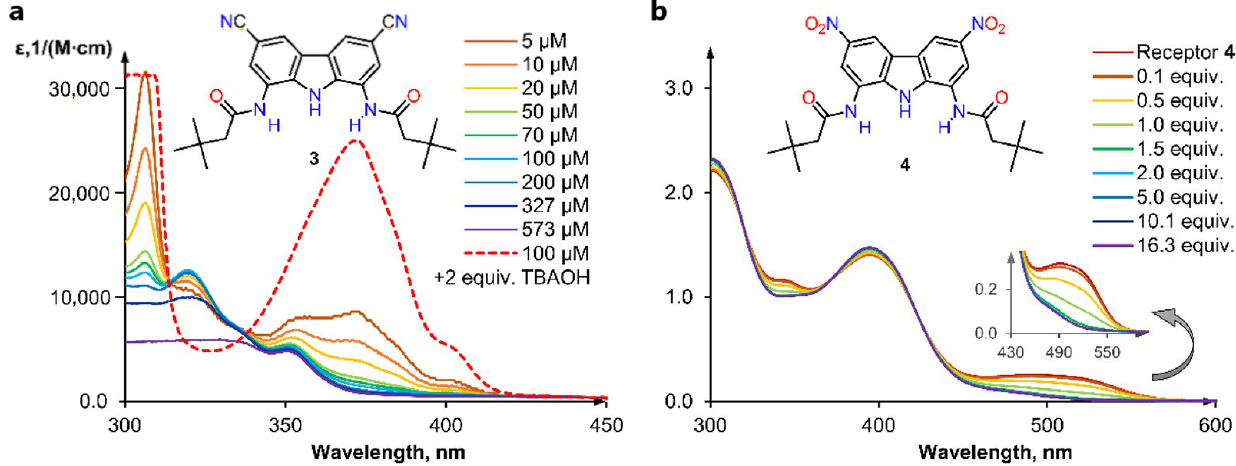
Figure 5. Self-ionization studies. ( a ) Self-ionization of diluted solutions of 3 in DMSO + 0.5% H 2 O at 298 K; ( b ) reversal of self-ionization of 4 (10 − 4 M) upon titration with TfOH in DMSO + 0.5% H 2 O at 298 K.